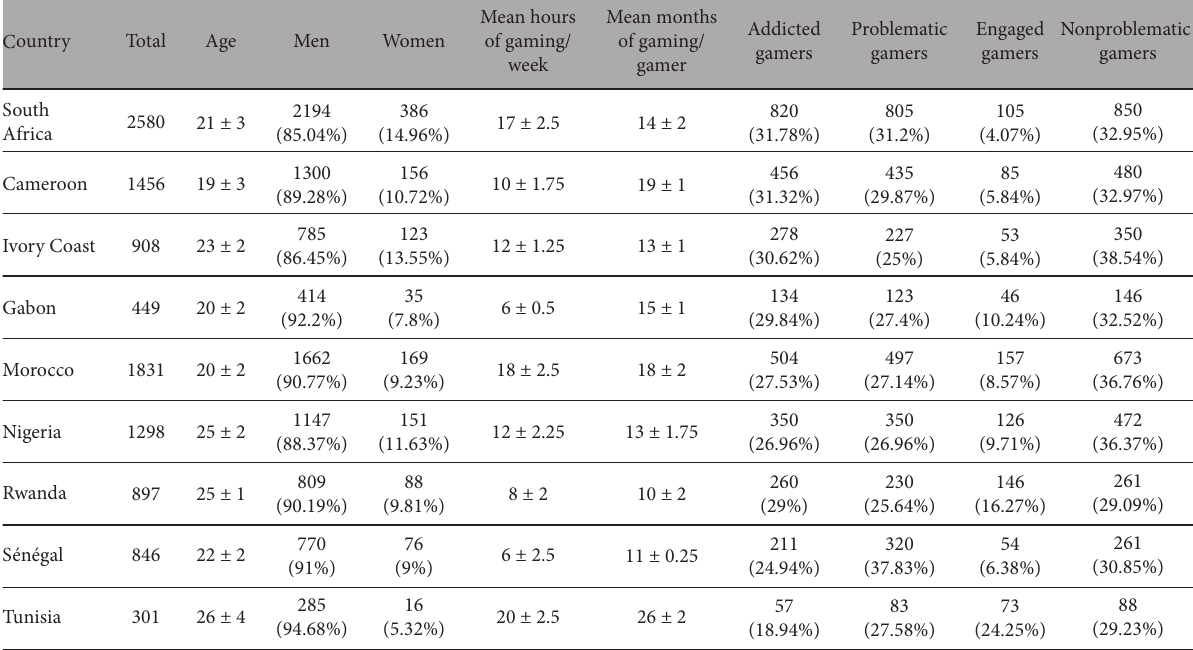
Figure 1: Descriptive epidemiology of gaming among the nine African countries where prevalence of gaming, mean hours of gaming per week, period from when participant considered himself a gamer, and type of device used for gaming purposes are described with age and sex